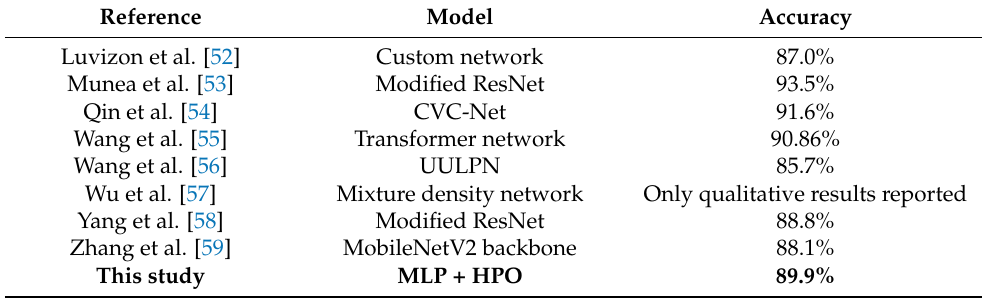
Table 12. Comparison with previous studies on posture recognition using MPII